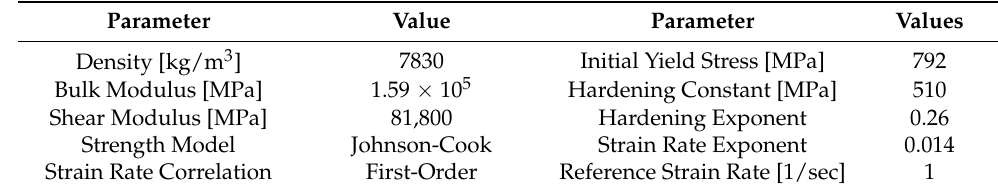
Table 2. Material parameters AISI 4340 Steel